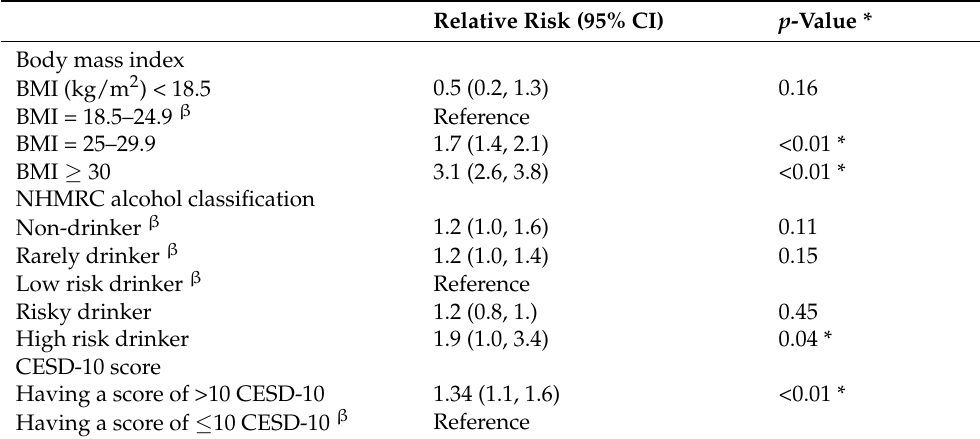
Table 5. Individual modifiable risk factors comparing individual risk factors between women with and without a history of HDP.